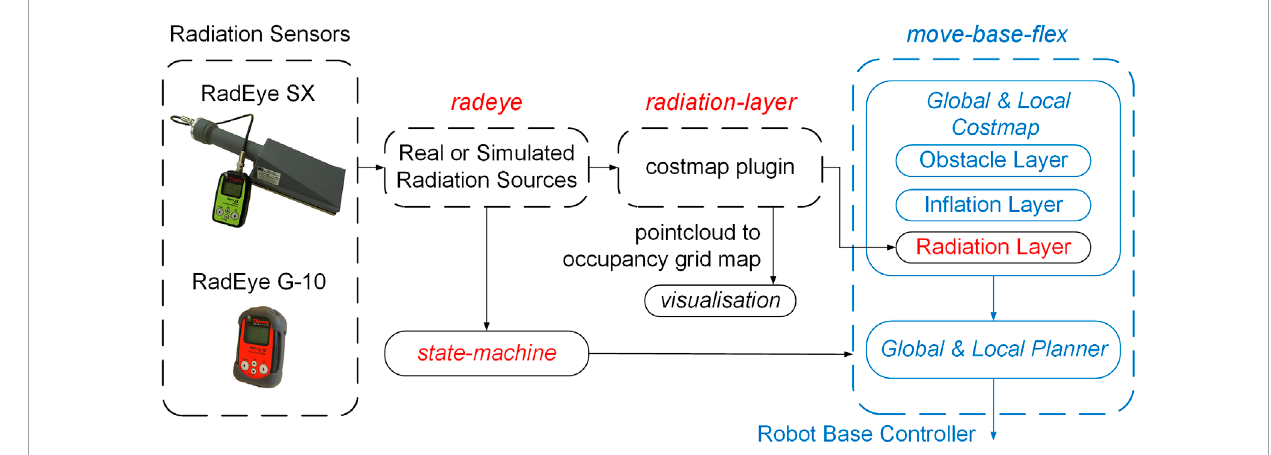
FIGURE 4 The schematic model of the sensors and packages for the radiation-aware navigation and mapping.